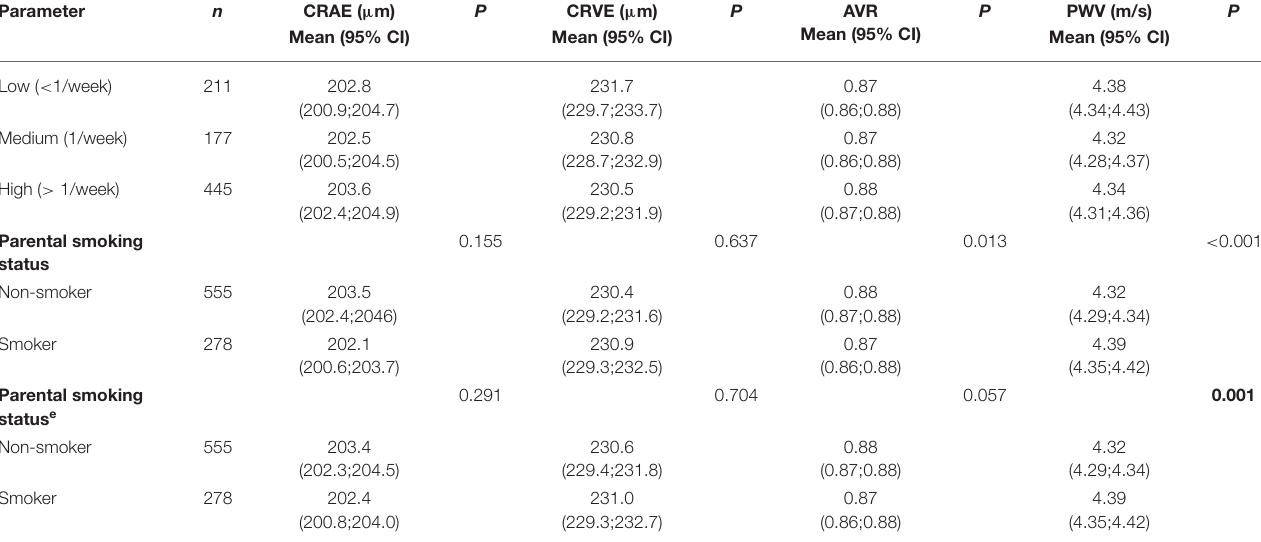
microcirculation (7). In our cohort, no association of migration background and PWV was observed. There is evidence that migration background is associated with CV risk factors such as childhood obesity and sedentary behavior (7, 9, 12). We recently